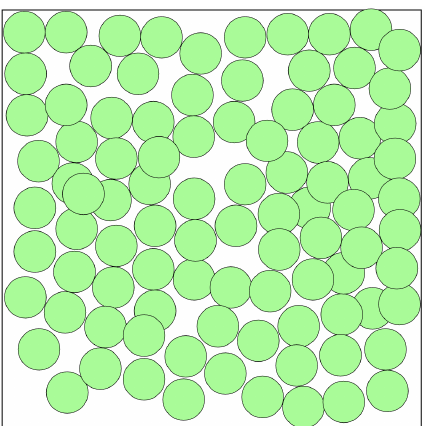
Figure 2. Example of random deployment